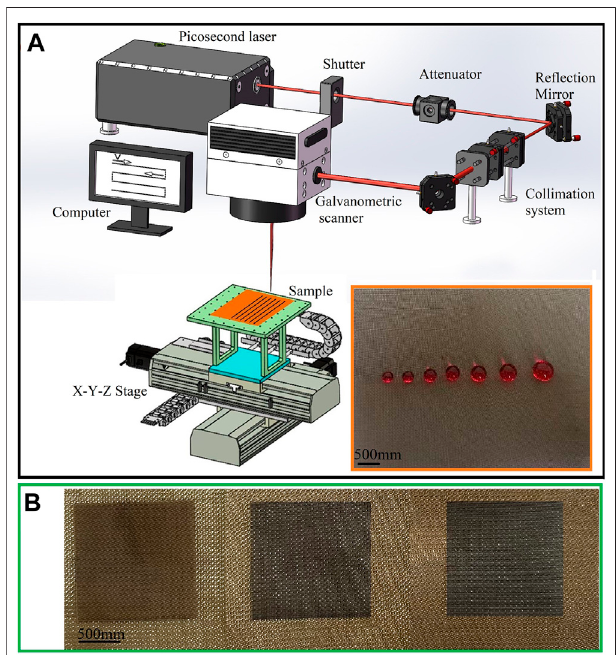
FIGURE1| The schematicofexperiment setup (A) and thesampleafter LT, LCT, and LTCTO (B)